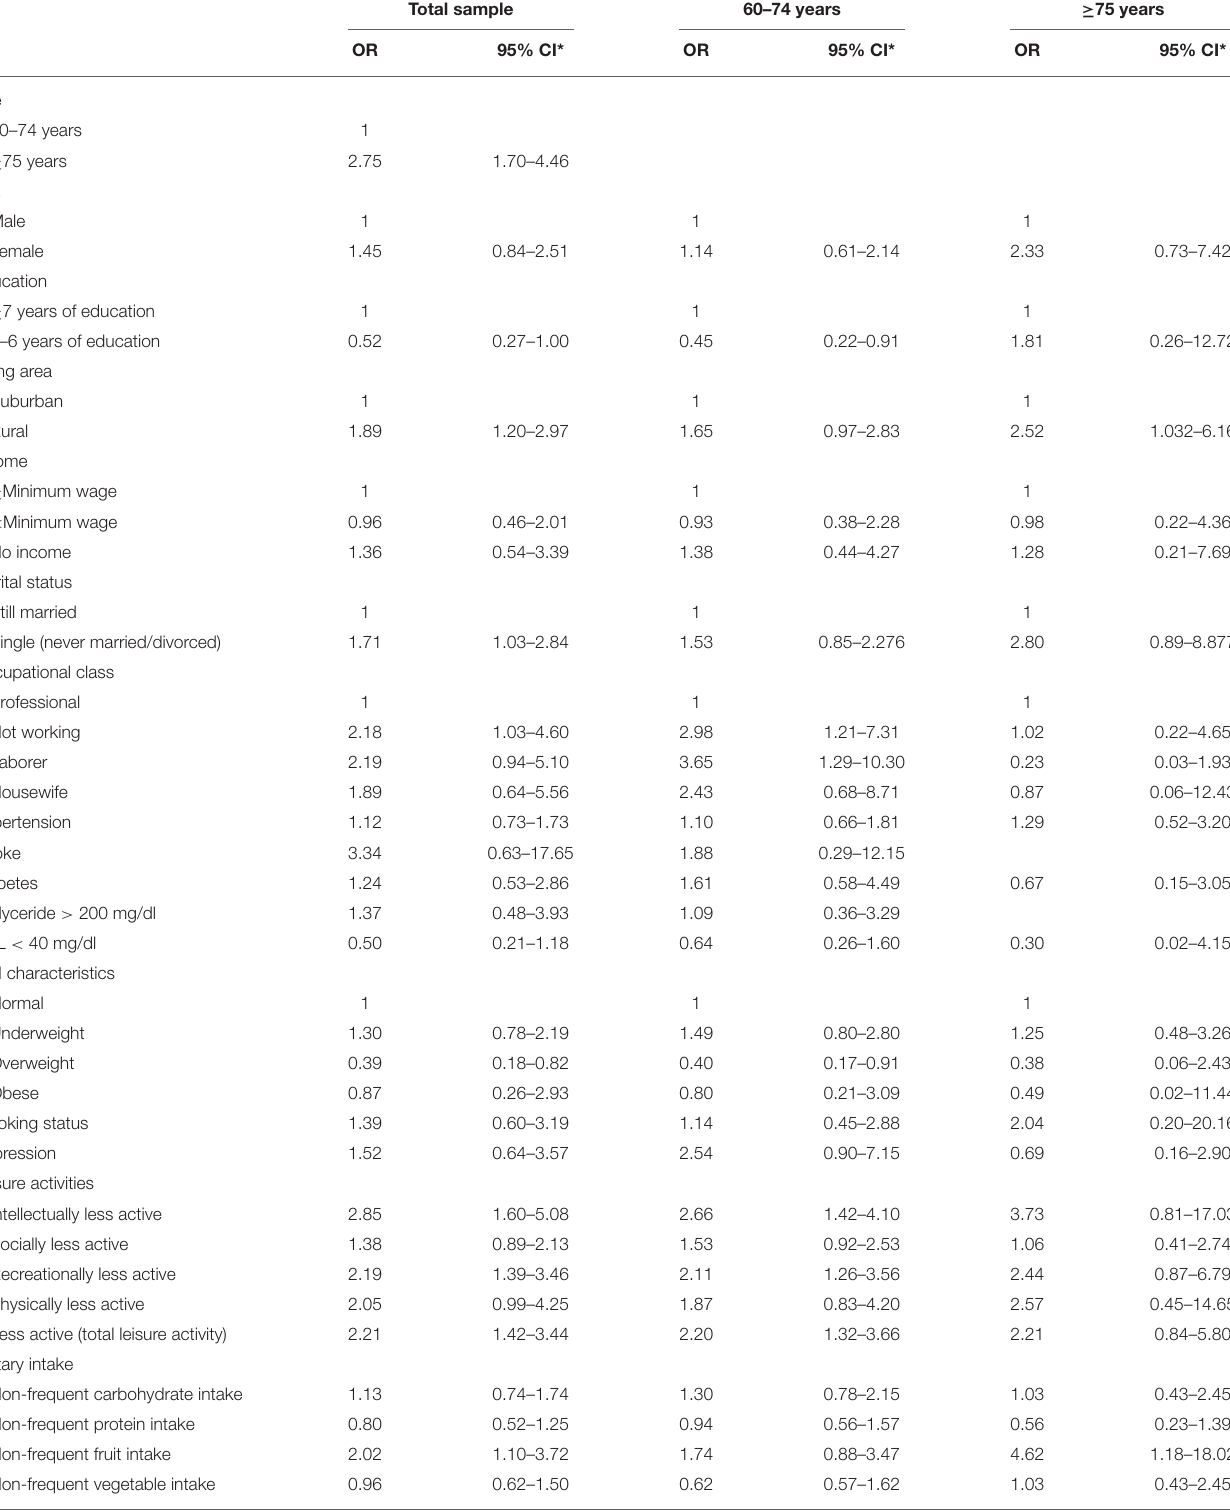
TABLE 3 | Multivariable models for the total sample ( n = 686) and stratified by